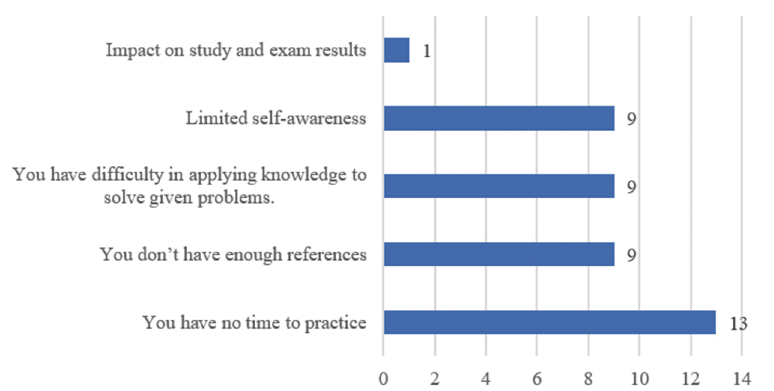
Figure 9. The difficulties when students study in class according to STEM